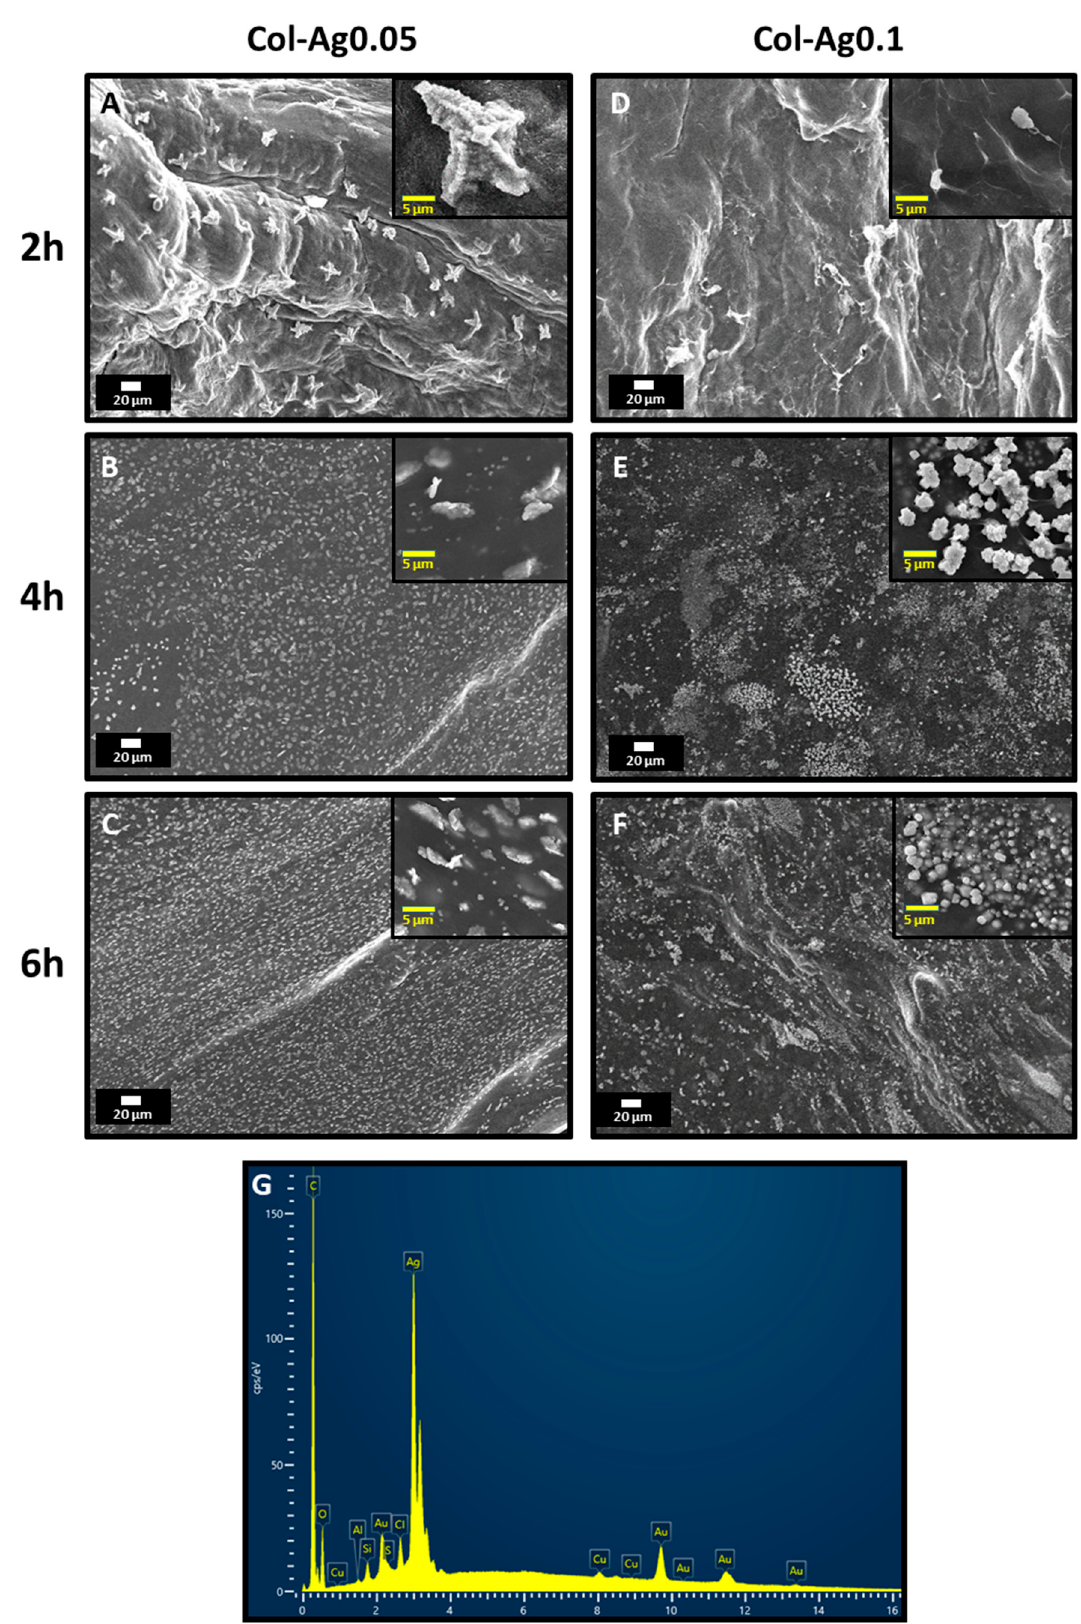
Figure 2. SEM images of A : Col-Ag0.05-2; B : Col-Ag0.05-4; C : Col-Ag0.05-6; D : Col-Ag0.1-2; E : Col-Ag0.1-4; F : Col-Ag0.1-6. G : Representative EDS analysis of Col-Ag.